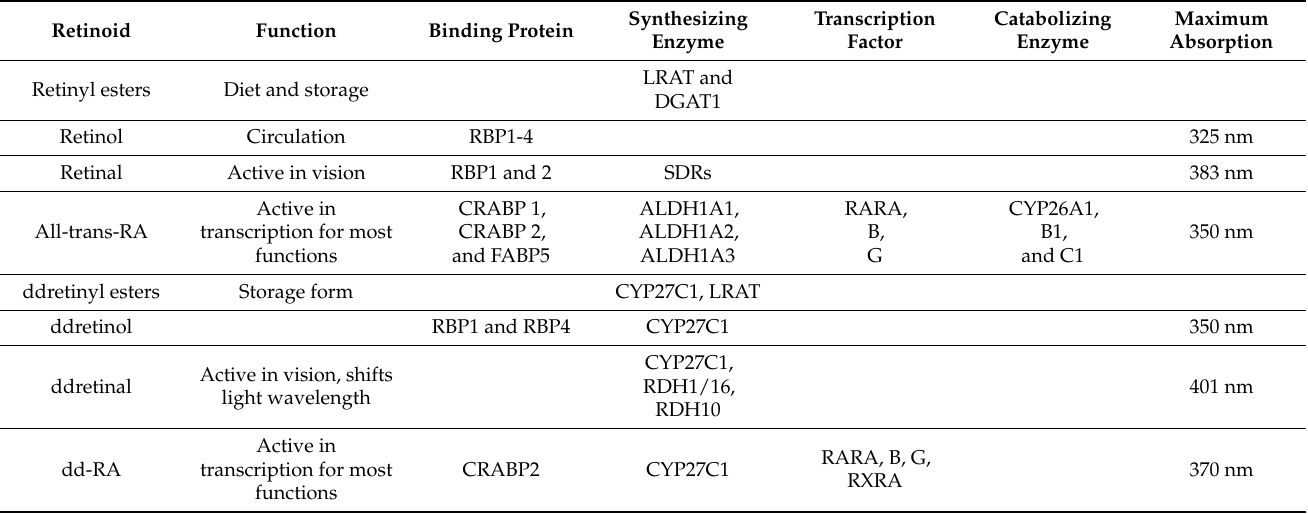
Table 1. Natural retinoids [21–23,25–37].